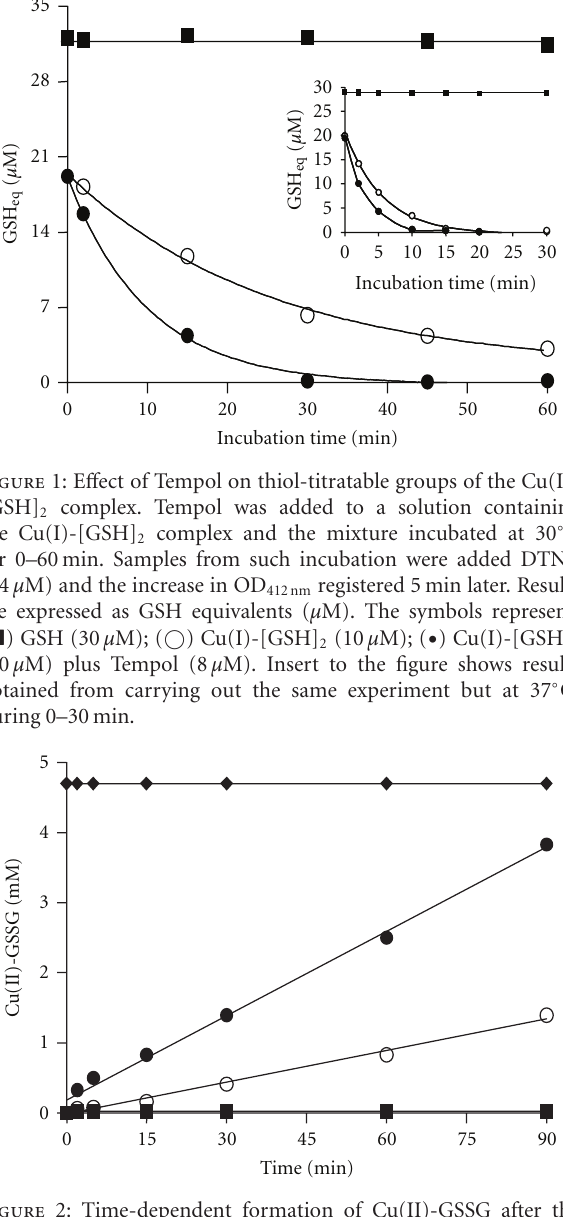
Figure 2: Time-dependent formation of Cu(II)-GSSG after the addition of Tempol to a Cu(I)-[GSH] 2 complex. Tempol was added to a solution containing the Cu(I)-[GSH] 2 complex and the mixture incubated at 37 ◦ C for 0–90 min. Samples were taken during the incubation and the increase in OD 625nm registered. Results are expressed as mM Cu(II)-GSSG concentration. The symbols represent: ( (cid:4) ) Cu(II)-GSSG (5mM); ( (cid:3) ) GSH (15mM); ( (cid:5) ) Cu(I)-[GSH] 2 (5mM); ( • ) Cu(I)-[GSH] 2 (5mM) plus Tempol